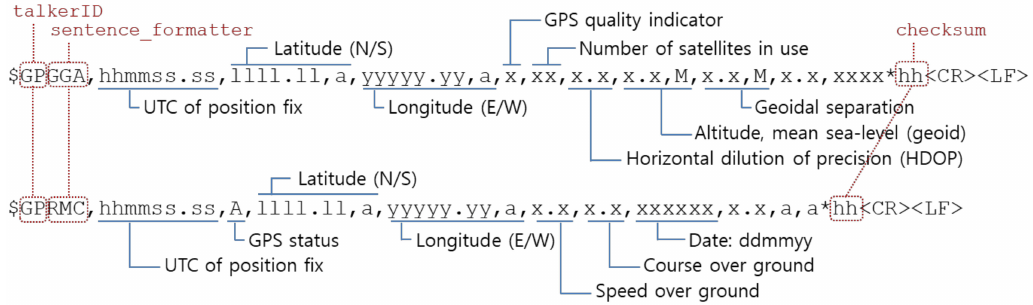
Figure 1. The National Marine Electronics Association (NMEA) format of GPS fix data (GPGGA) and recommended minimum specific GNSS data (GPRMC)